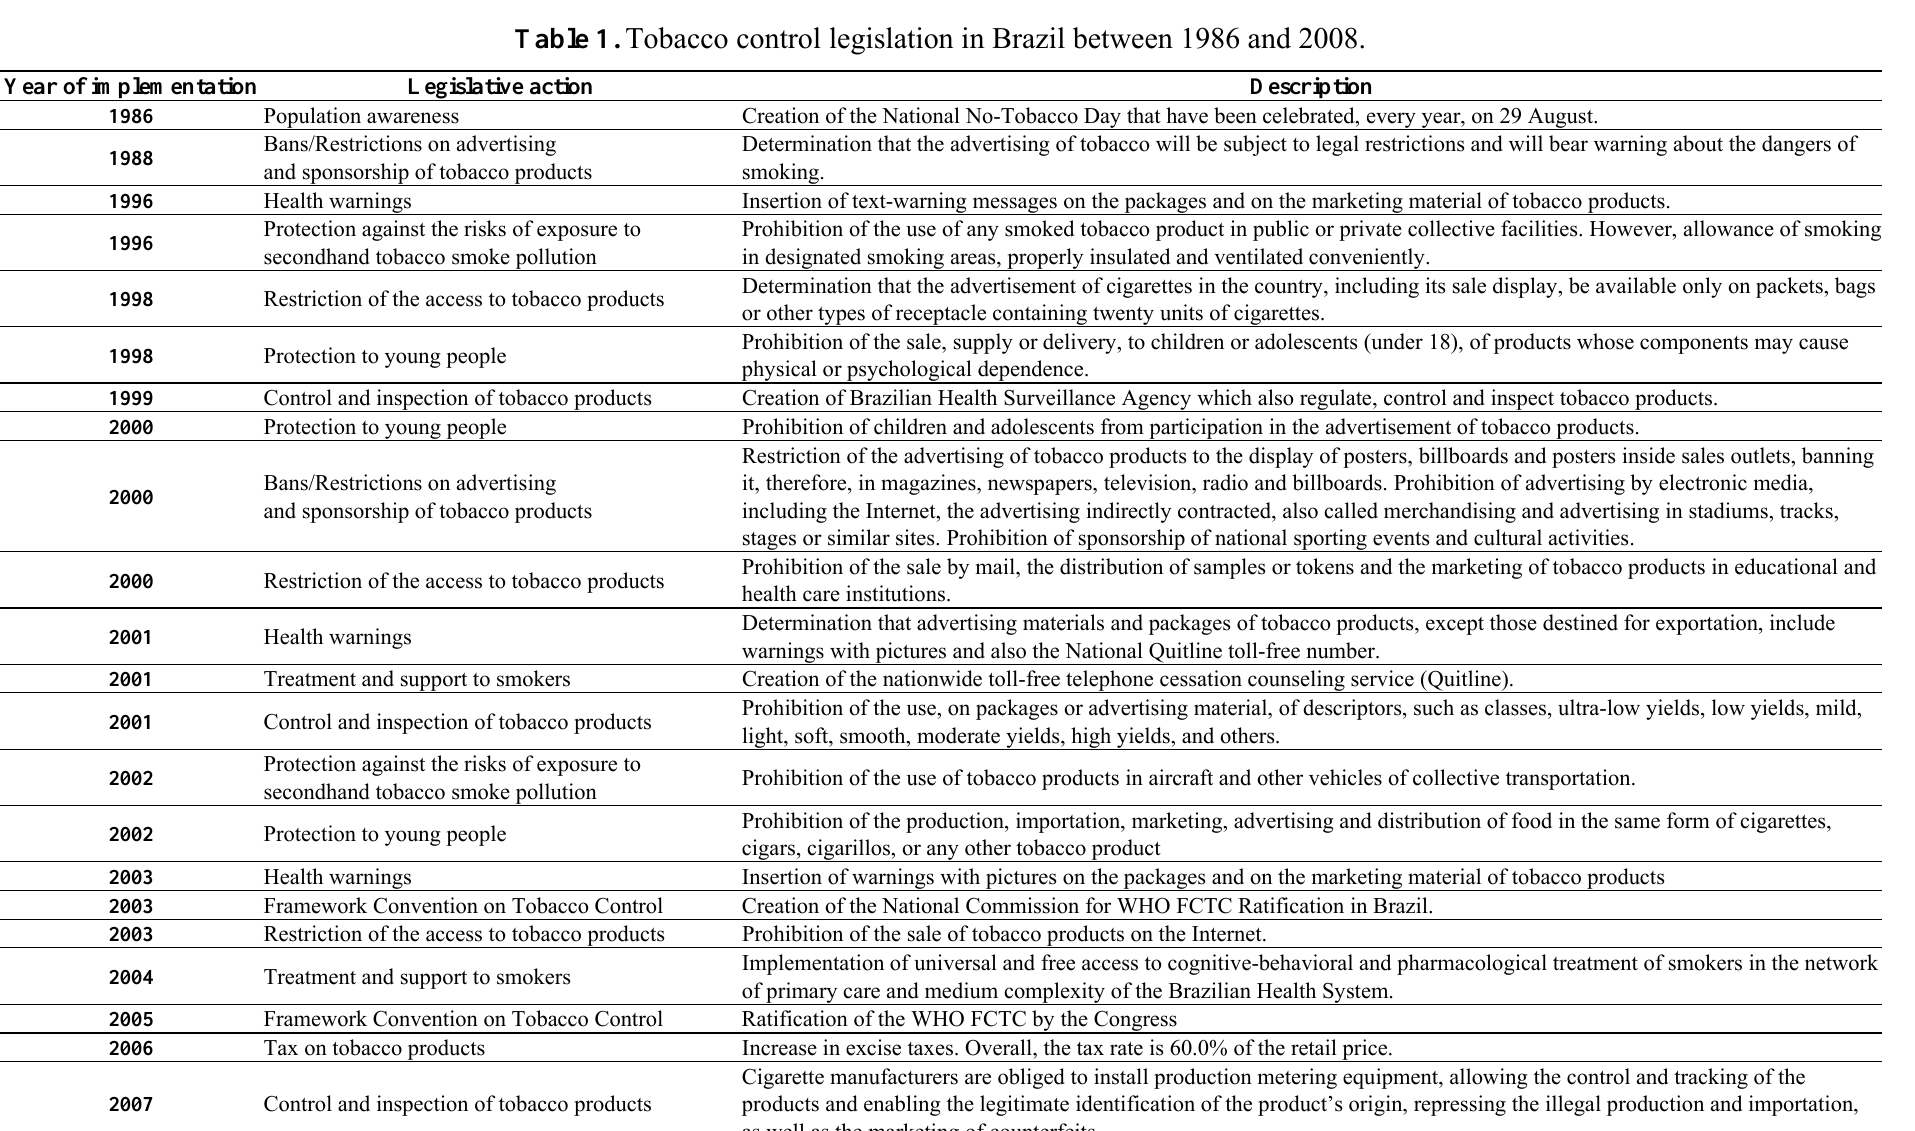
Table 1. Tobacco control legislation in Brazil between 1986 and